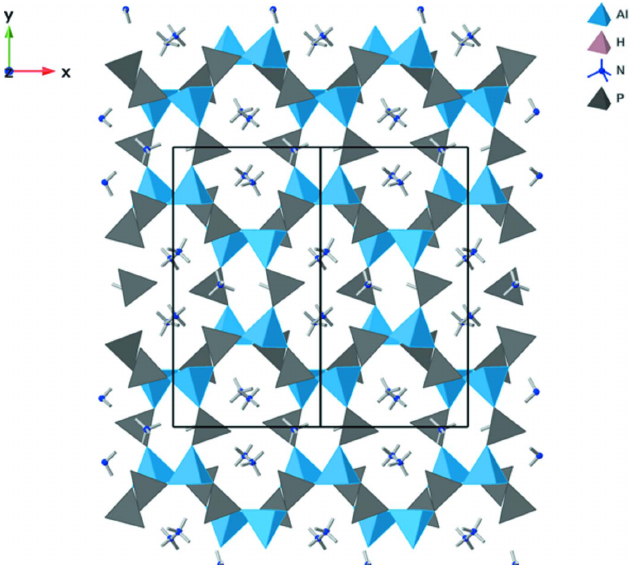
Figure 1 Polyhedral representation of (NH 4 ) 3 Al 2 (PO 4 ) 3 , showing the overall connectivity and ion channels in the crystal structure. Al is in the center of blue tetrahedra, P in gray tetrahedra, and N is represented by blue spheres.